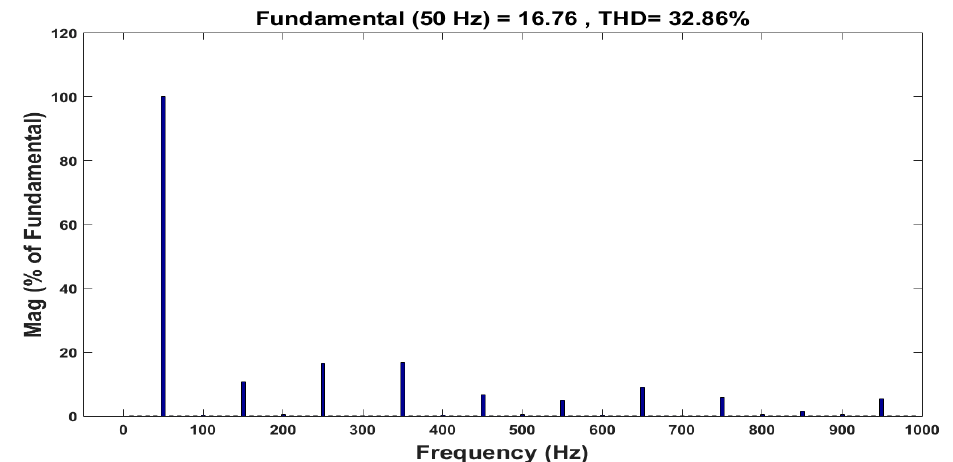
Figure 20. Simulated FFT analysis of boost mode inverter output with THD.